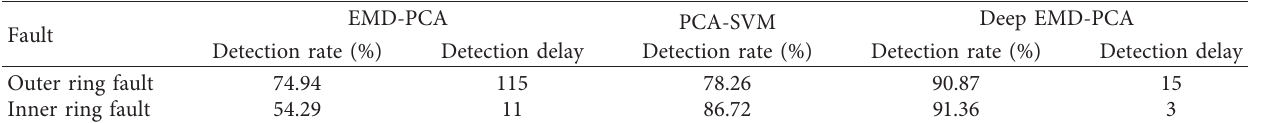
Table 2: Experimental performance comparison of mechanical failure